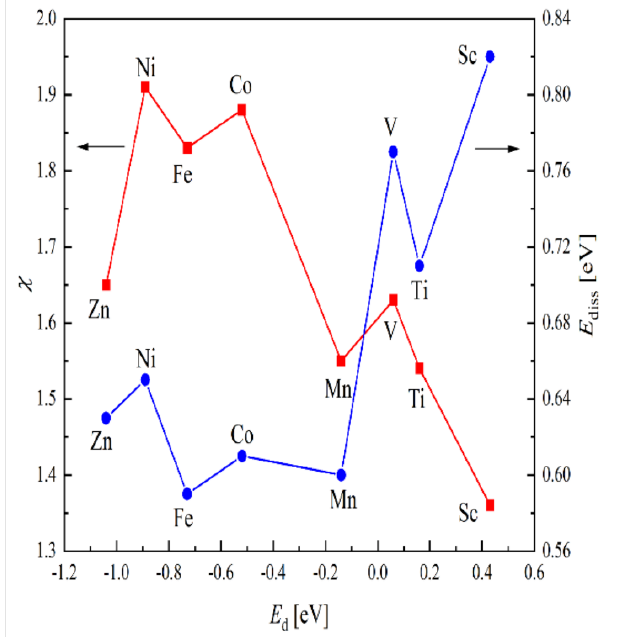
Figure 27. Electronegativity (Pauling scale) of TM and E diss depending on the d band center of TM-doped Mg. E diss and d band center come from Table 7, the electronegativity (Pauling scale) of TM come from reference